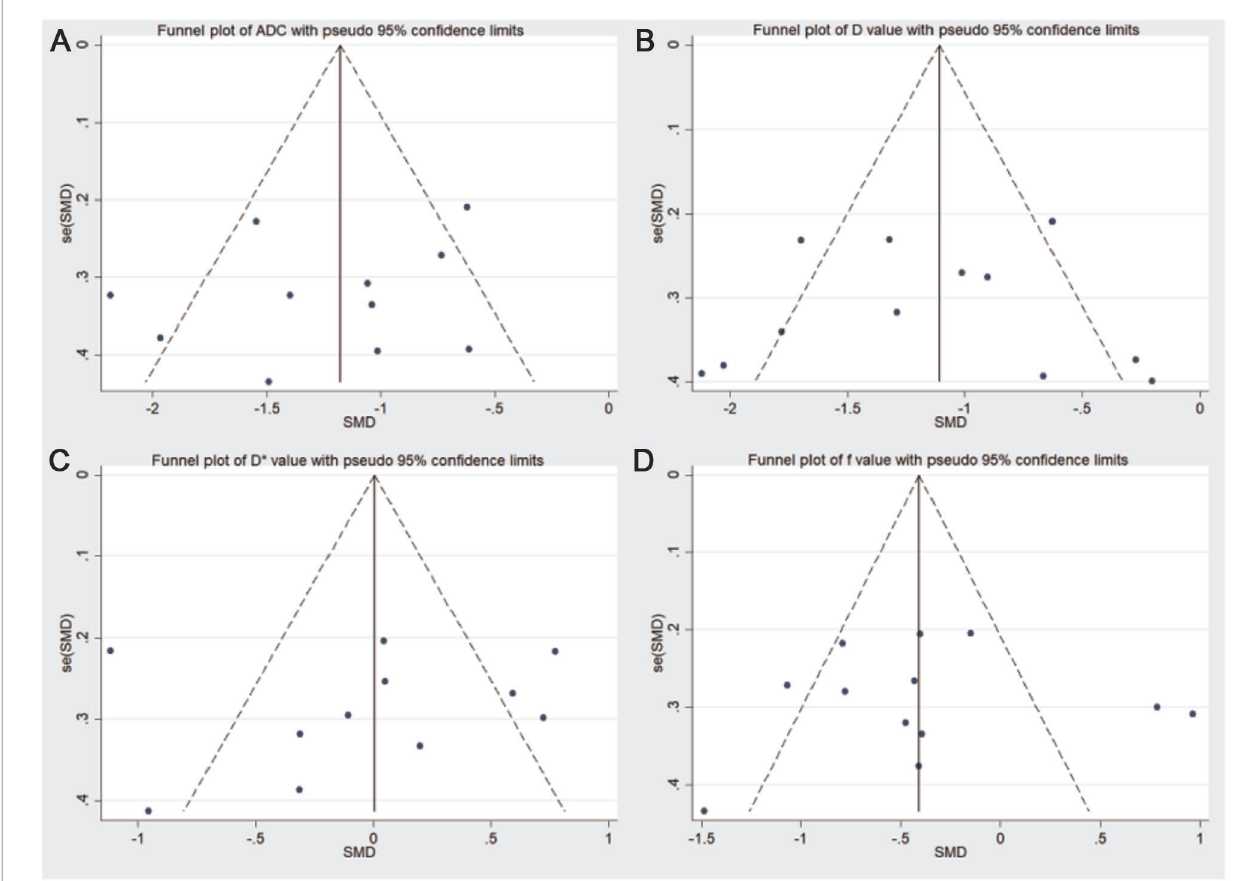
FIGURE 3 | Funnel plots. ( A ) Apparent diffusion coef fi cient (ADC value); ( B ) tissue diffusivity ( D value); ( C ) pseudo-diffusivity ( D * value); and ( D ) perfusion fraction ( f